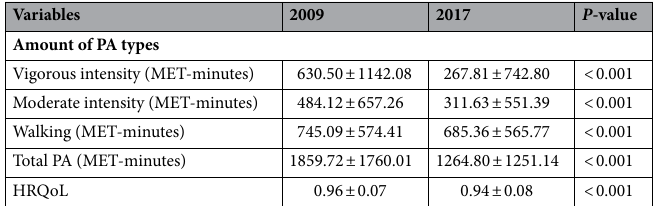
Table 2. Comparison of PA and HRQoL between 2009 and 2017. Values are presented as mean ± standard deviation. PA physical activity, HRQoL health-related quality of life.